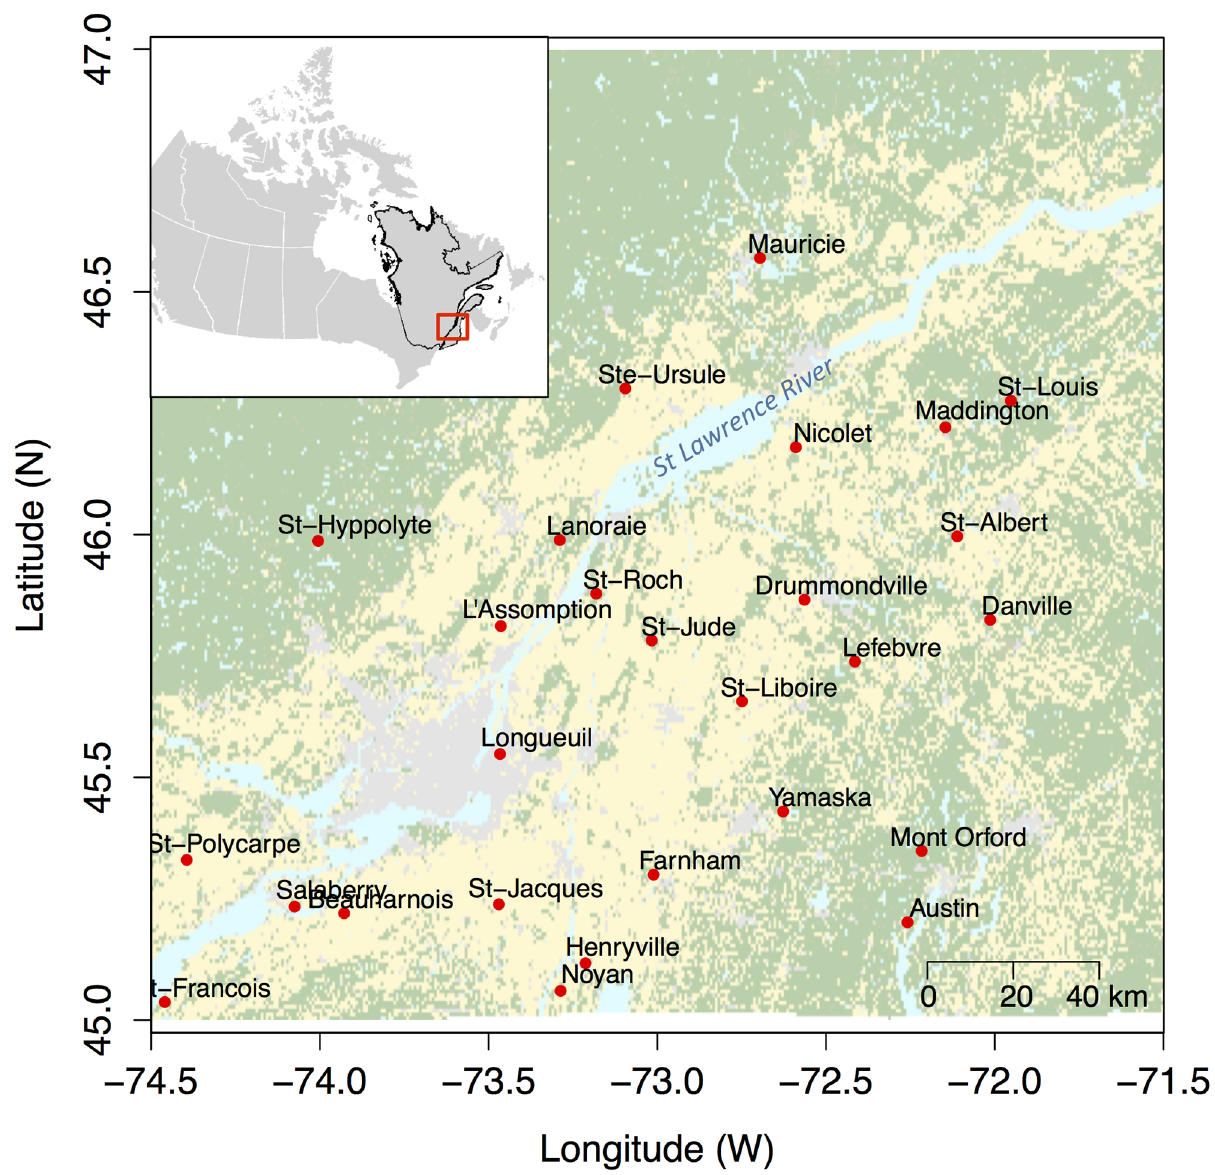
Fig 1. Location of the 26 study sites sampled during the summer 2011 in southern Québec. An additional site (Saguenay) is located further north-east and is not shown on this